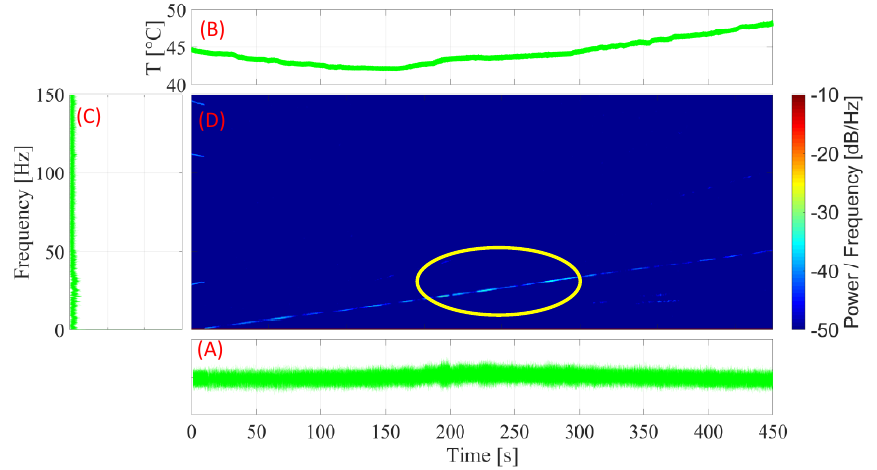
Figure 16. Curve for the SMA-SE M-Shape device with pre-load of 1.5 mm: ( A ) amplitude × time; ( B ) temperature × time; ( C ) FFT; ( D ) spectrogram.